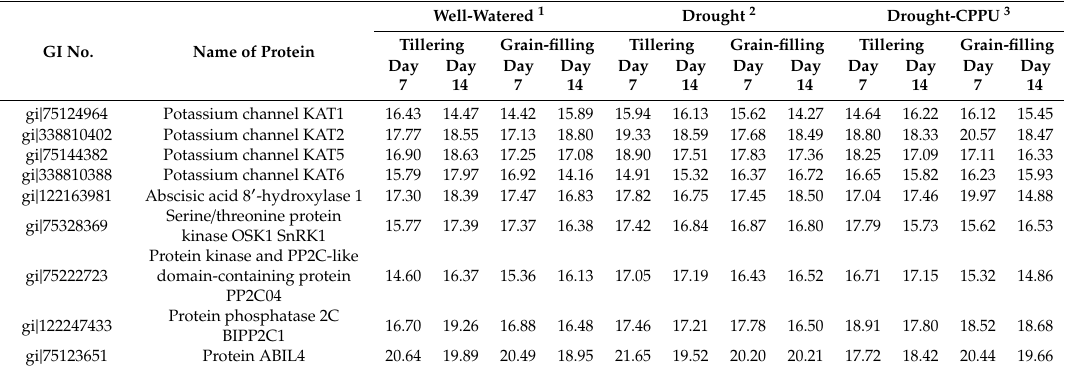
Table 1. Rice flag leaf proteins (related to stomatal conductance) with unchanged abundance intensities in di ff erent treatments. The highest log2 intensity value among the three technical replicates was used as the representative value of that treatment.